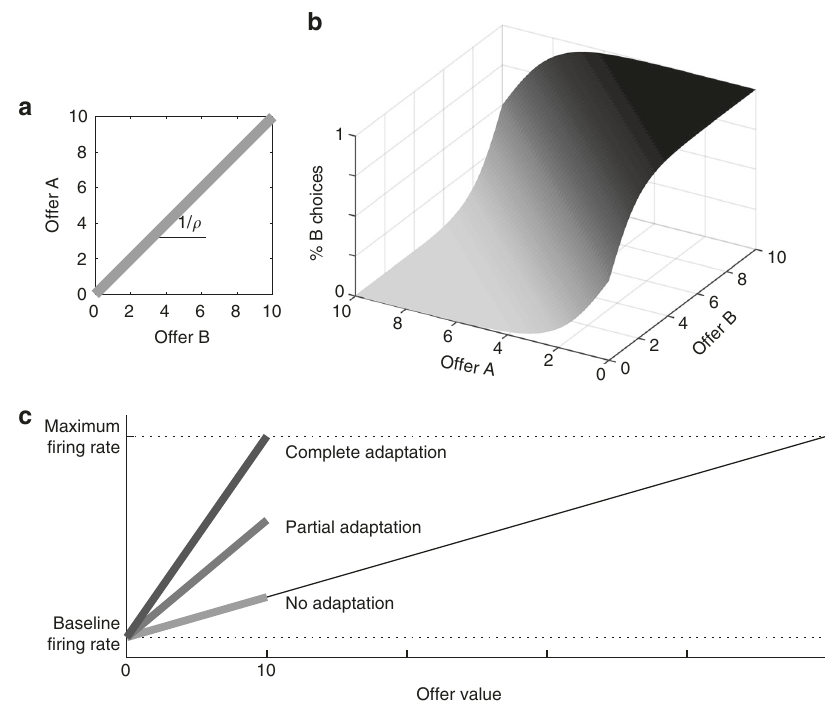
Fig. 4 Possible adaptation scenarios. a Indifference line. We indicate with q A and q B the quantities of good A and good B, respectively. Across trials, q A varies in the range [0, Q A ], while q B varies in the range [0, Q B ]. In the plane de fi ned by q A and q B , we de fi ne the “ indifference curve ” as the set of offers for which the animal splits decisions equally between the two goods. We assume that the indifference curve is a straight line on this plane. Thus the relative value between the two goods, referred to as ρ , is de fi ned by the slope of the indifference line (slope = 1/ ρ ). b Choice pattern. Given offers of goods A and B, a choice pattern can be represented as a sigmoid surface, in which the z -axis represents the likelihood of choosing good B. For each pair of offers, one of the two options provides a higher payoff, depending on whether it is above or below the indifference line. However, unless the sigmoid is a step function, in some trials the animal fails to choose that option (choice variability). Given a set of offers and a relative value, the expected payoff is an increasing function of the sigmoid steepness. c . Adaptation scenarios. In this cartoon, offer values in the current context vary in the range [0 10]. The light line represents a hypothetical scenario in which there is no range adaptation (see Results). The darker lines represent the scenarios with partial and complete